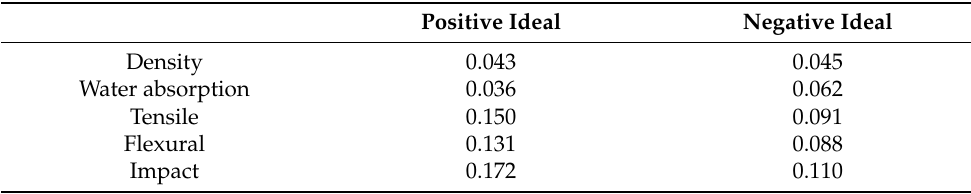
Table 9. The positive and negative ideal values.